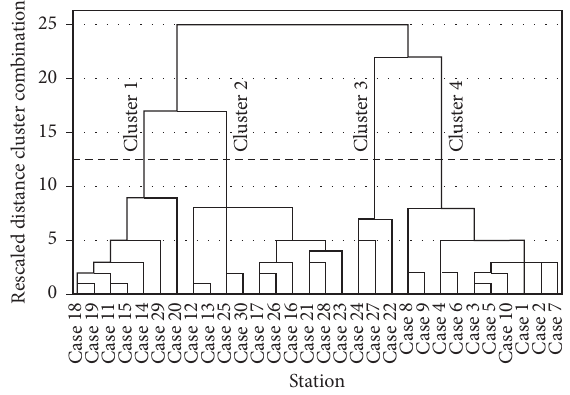
Figure 4: Clustering of the 30 sampling stations along the Batang Baram and its